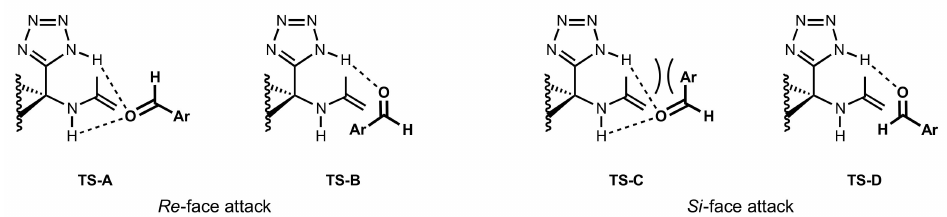
Figure 28. Transition states of the aldol reaction catalysed by the sugar tetrazole